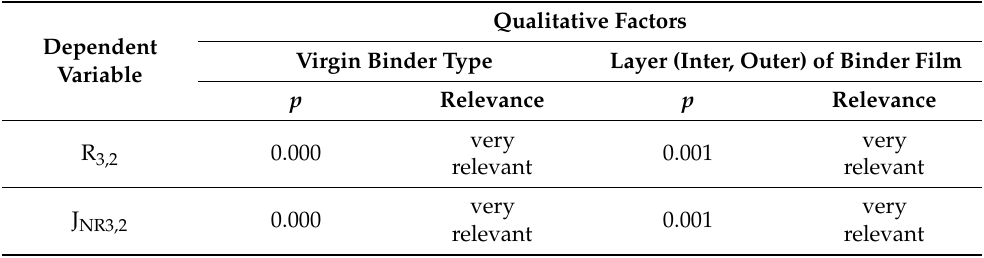
Table 8. Summary of the ANOVA analysis for the R 3,2 and J NR 3,2